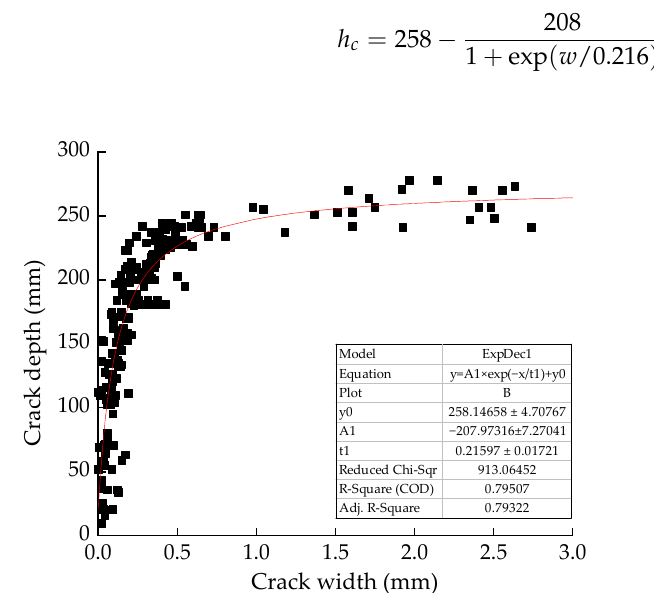
Figure 10. Curve fitting on crack depth and width.